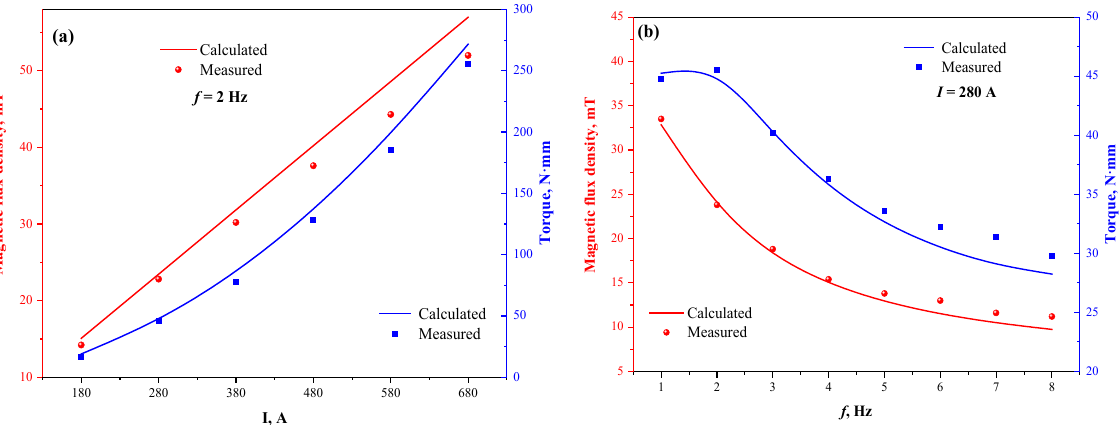
Figure 5. Comparison between measured and calculated values of magnetic flux density and probe torque at the center point of the stirrer: ( a ) different current intensities; ( b ) different current fre- quency.